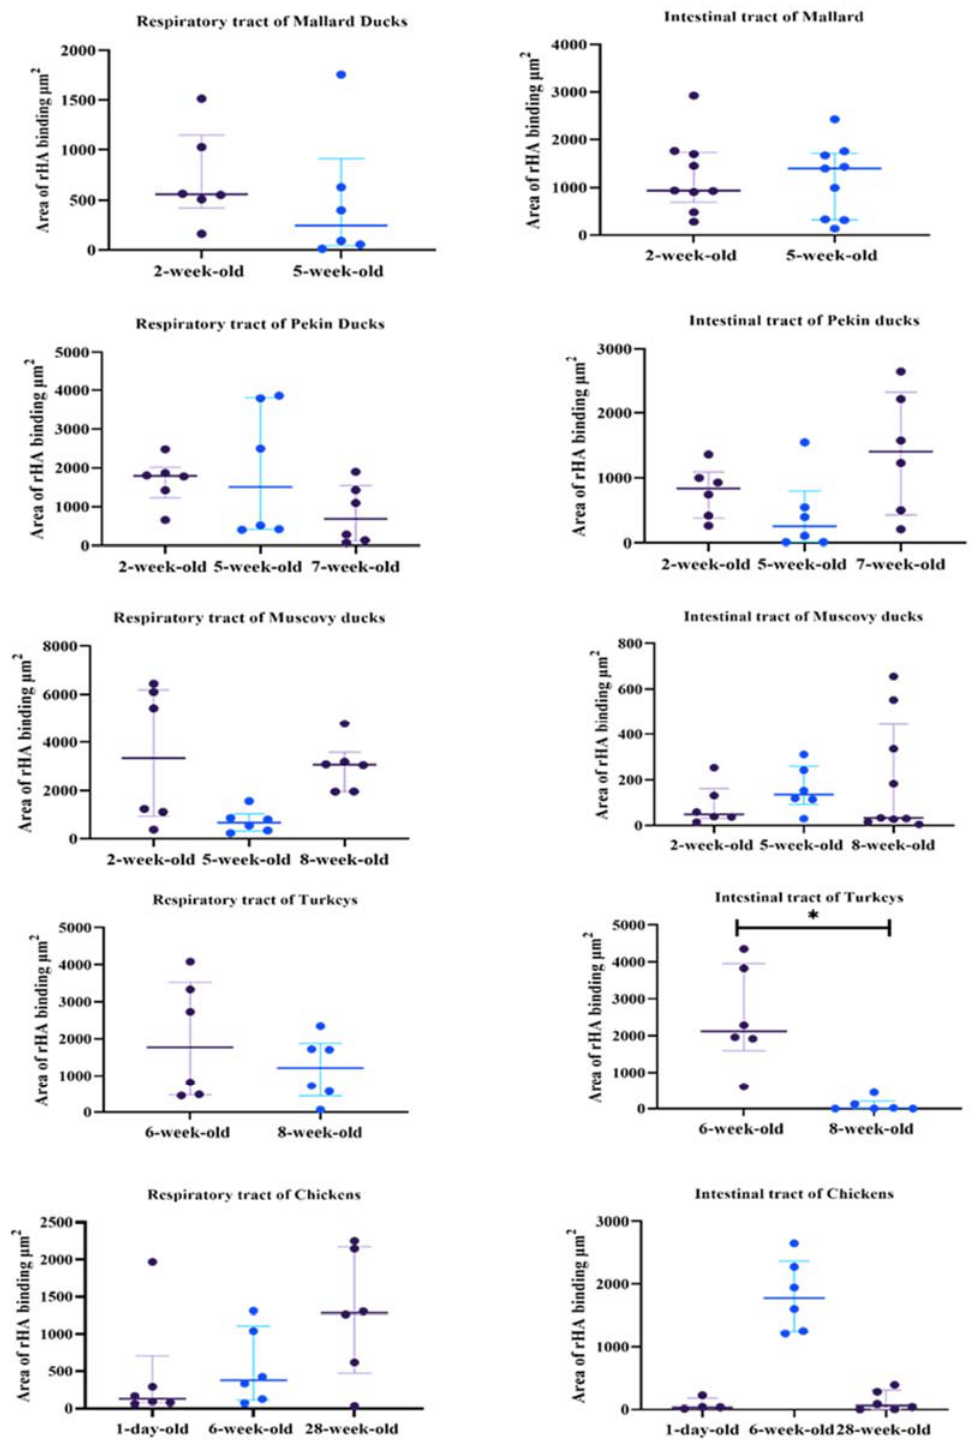
Figure 5. Dot plot charts showing the binding scores for HPAIV rHA in the respiratory (trachea and lung) and intestinal tract (upper intestine and lower intestine) of chickens, turkeys, and Mallard, Pekin, and Muscovy ducks. Dots represent the binding score for each tissue. Note significant age-related differences in MAB scores in the respiratory and intestinal tracts of the turkey. Statistical significance denoted by asterisks. Kruskal–Wallis test and Mann–Whitney U test ( p ≤ 0.05) were used. Graphs formulated in Graph Pad Prism 9.0.0.(GraphPad Software, San Diego, CA, USA).